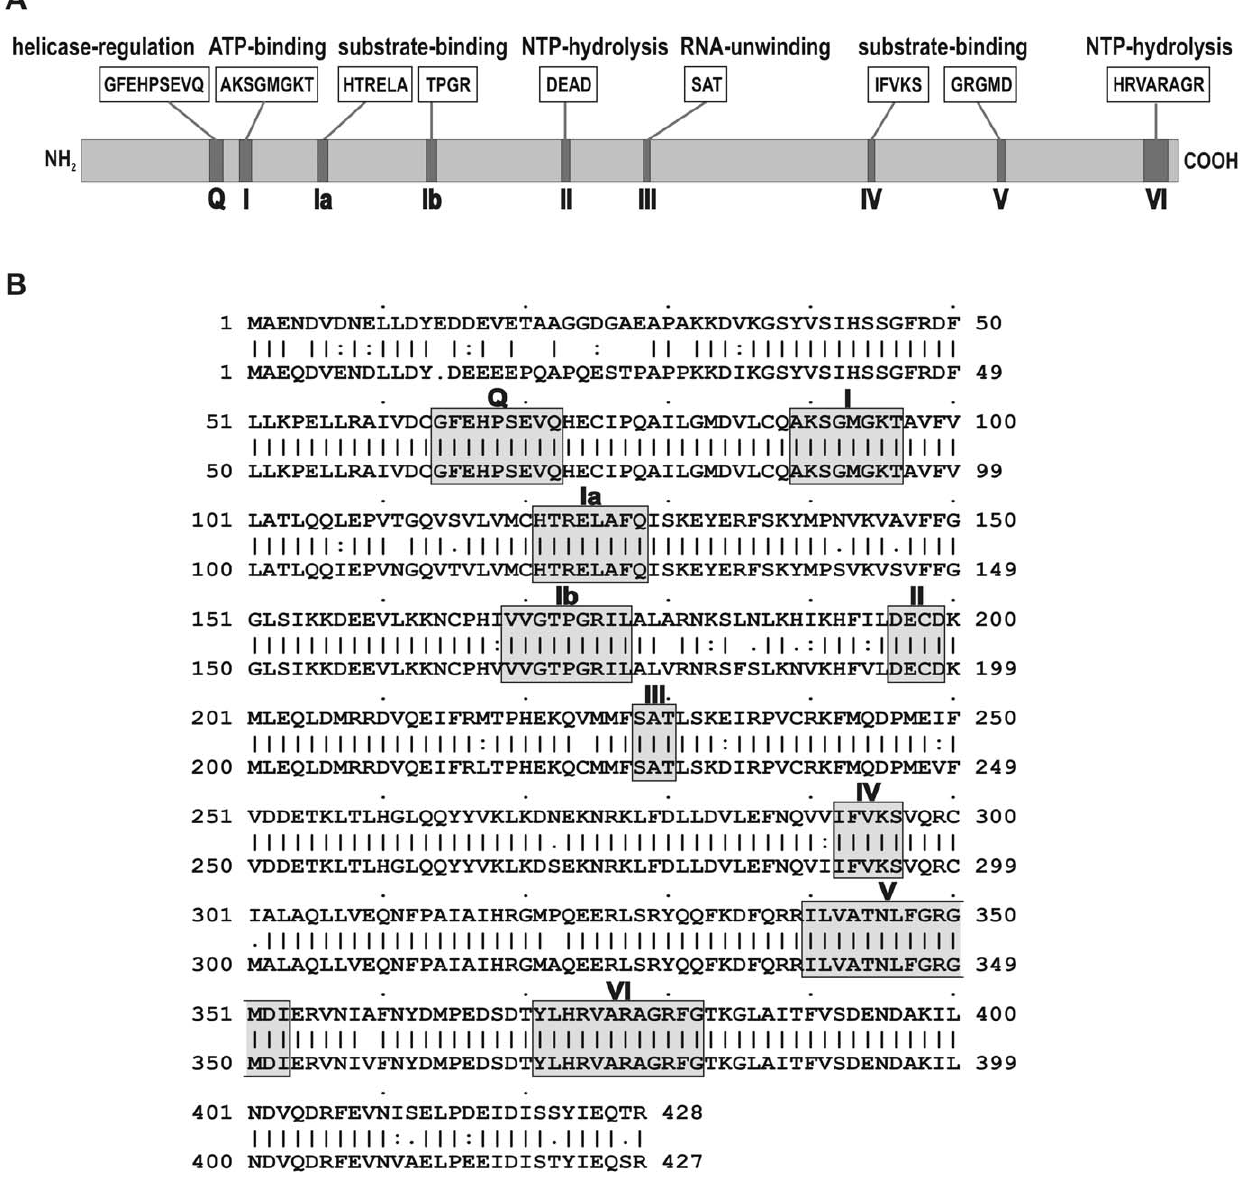
Figure 1. DExD/H-box RNA-helicases UAP56 and URH49: (A) Schematic representation of a DExD/H-box RNA helicase. The conserved helicase motifs are indicated by shaded boxes and roman numerals. The known or supposed function of the respective DExD/H-box motif, along with its consensus amino acid sequence is highlighted above the protein. (B) Alignment of the 428 amino acids of UAP56 (upper strand) and the 427 amino acids of URH49 (lower strand). The above mentioned DExD/H-box RNA-helicase motifs are indicated by shaded boxes with their respective roman numeral.